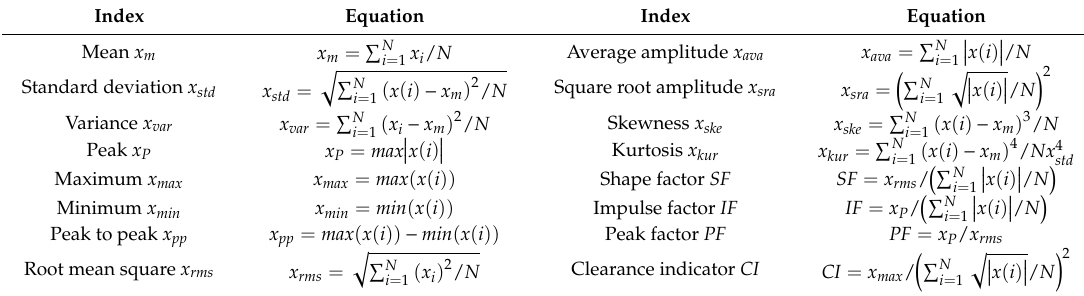
Table 1. Sixteen indexes in time domain.